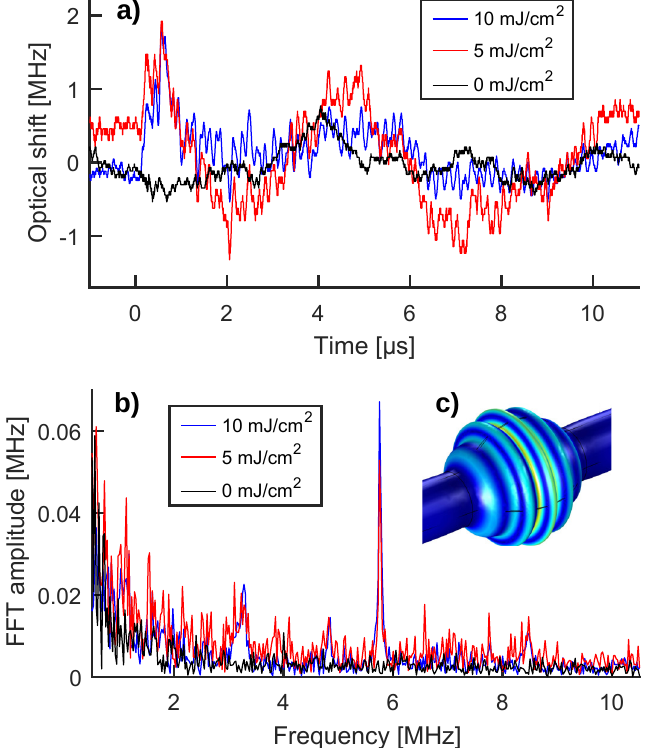
Figure 3. ( a ) Optical shifts induced in the WGM resonance by environmental noise (black curve) and by a PA wave (blue curve) as deduced from the raw transmission signals shown in Figure 2c keeping the same color code. The shift produced by a 5 mJ/cm 2 fluence pulse is added for comparison (red curve). ( b ) Fourier spectrum of the optical shifts reported in panel (a), keeping the same color code. ( c ) Deformations of the MBR walls (in arbitrary units) for a breathing mode close to 5.75 MHz, as deduced by solving the eigenvalues problem for the MBR system through COMSOL Multiphysics ® . Blue means less deformation, while yellow means more